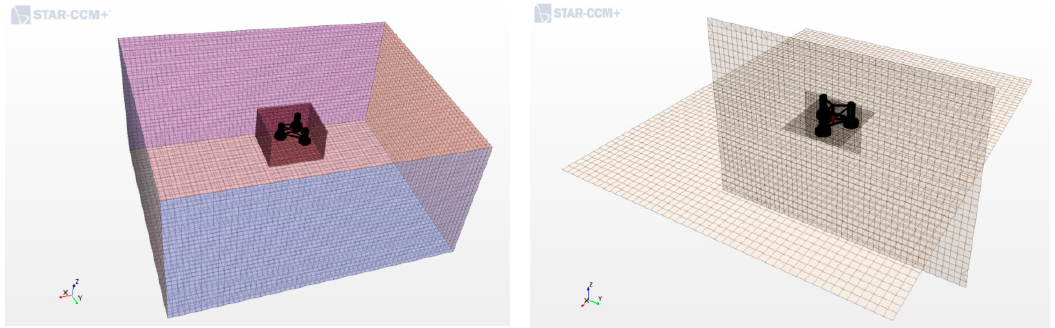
Figure 27. Schematic of numerical simulation mesh.